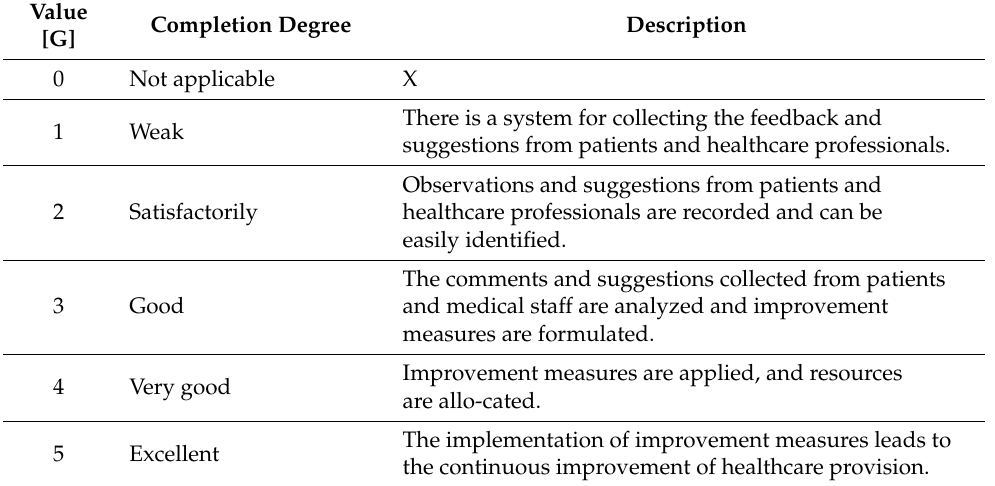
Table 18. Indicator evaluation grid R.A.2—Freedom of expression assurance.